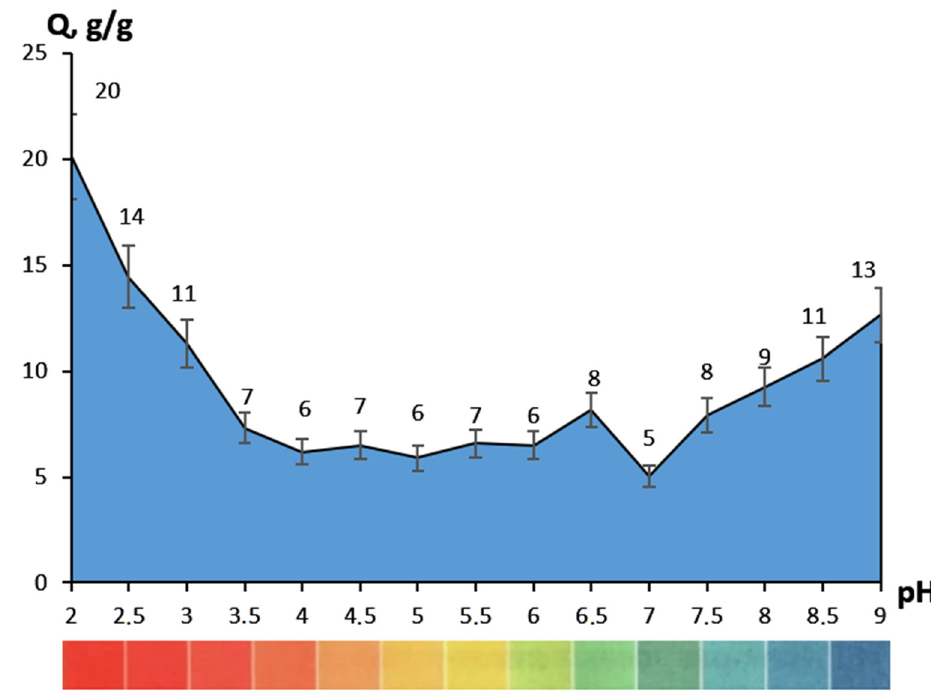
Figure 4. Sorption capacity regarding to the pH of buffer saline. Table 1. Sorption parameters of HP-Fe